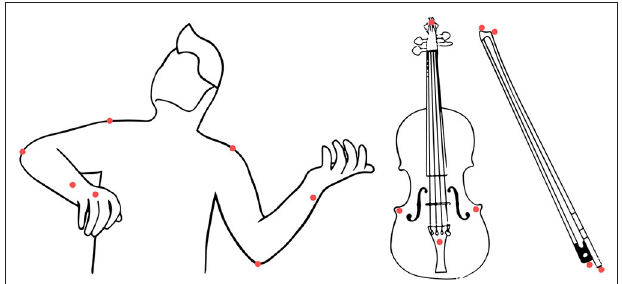
FIGURE 2 | Placement of the markers on the violinist body, the violin, and the bow.